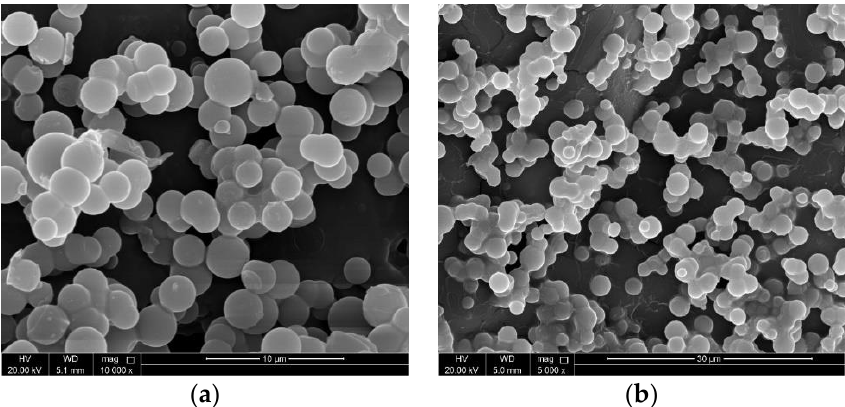
Figure 3. Trial-2 (0.50 g AOT) microcapsule SEM images for scales of ( a ) 10 µm and ( b ) 30 µm.